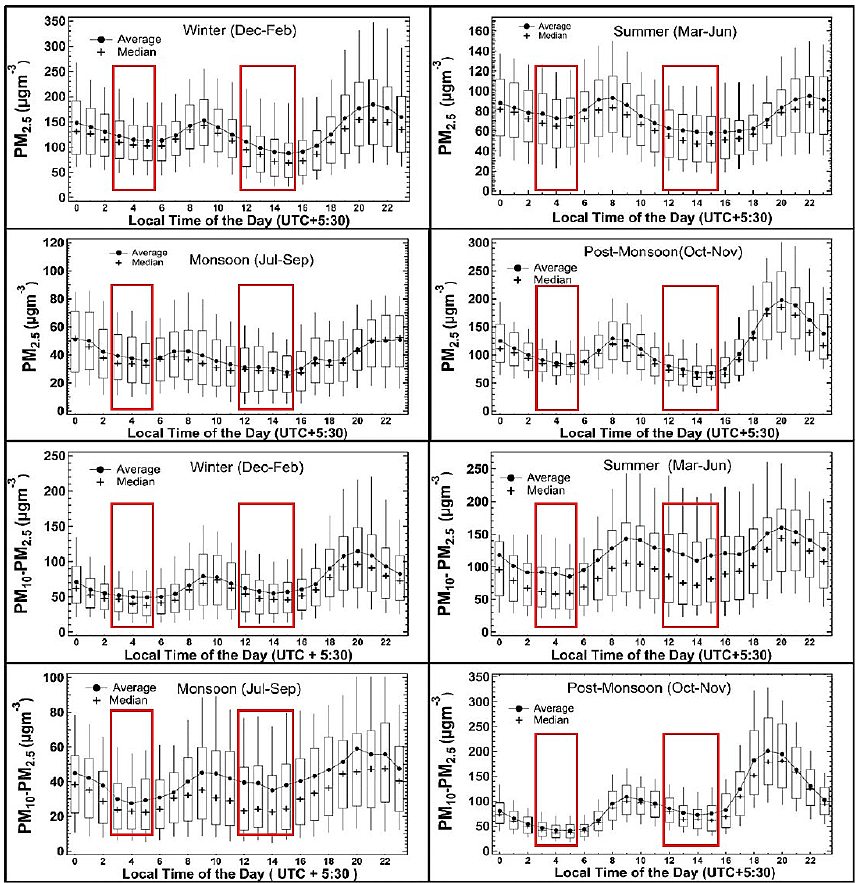
Figure 3. Diel box and whisker plots for fine-mode (top four panels) and coarse-mode (bottom four panels) particulate matter for the winter, summer, monsoon and post-monsoon seasons for the period November 2011 to August 2013 respectively. The box indicates the upper and lower quarter values; the cross indicates the median and the dots connected by lines provide the mean. The whiskers indicate the 5th and 95th percentiles respectively. Periods of calm ( < 1ms − 1 ) have been excluded while preparing the graph. The interval highlighted in red shows the daytime low (12:00 to 16:00LT) and nighttime low (03:00 to